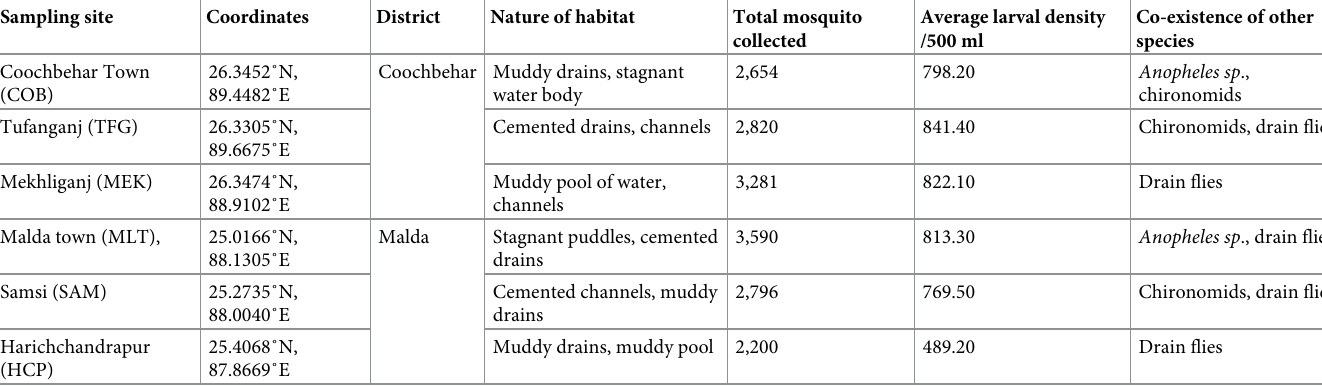
Table 1. Sampling details of Cx . quinquefasciatus from Coochbehar and Malda districts of West Bengal. Sampling